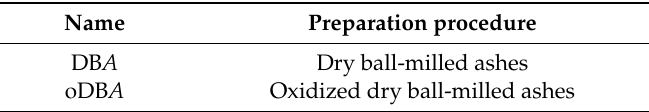
Table 1. Names and preparation procedures of the carbon-based fillers.